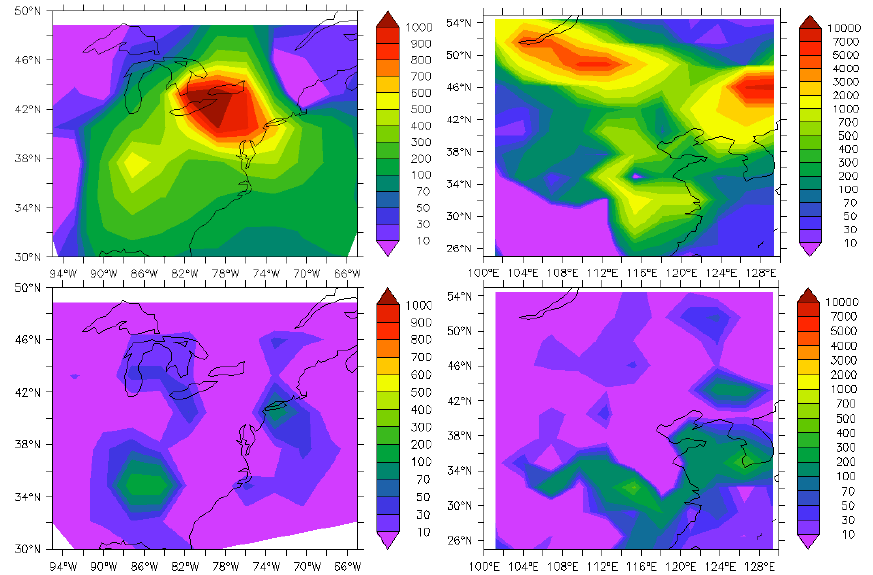
Fig. 11. Simulated monthly mean change in the aerosol number concentrations (cm − 3 ) near the surface over the eastern US (left) and China (right) during winter (January, upper panels) and summer (July, lower panels) due to HONO enhancement in the model.